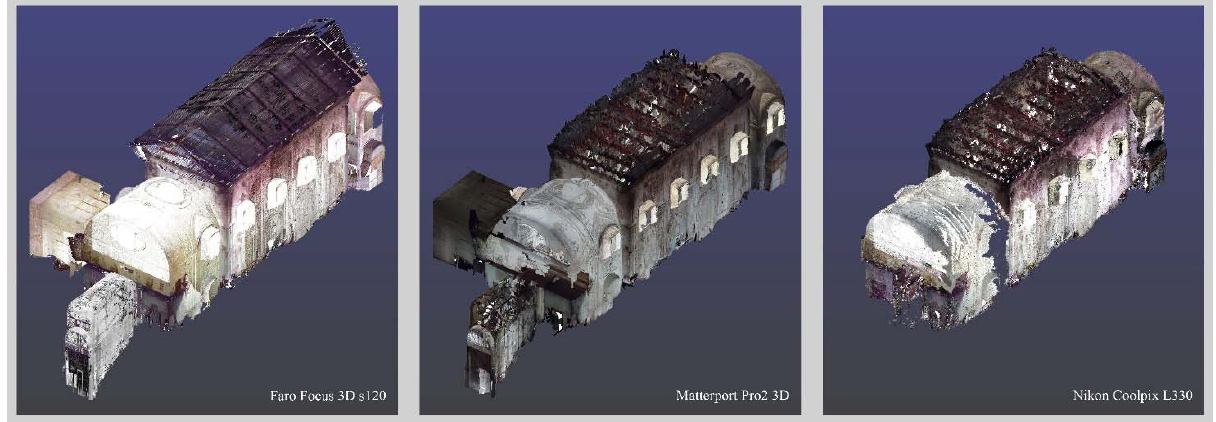
Figure 7: Point clouds of different acquisitions: Faro Focus 3D s120, Matterport Pro2 3D, Nikon Coolpix L330.